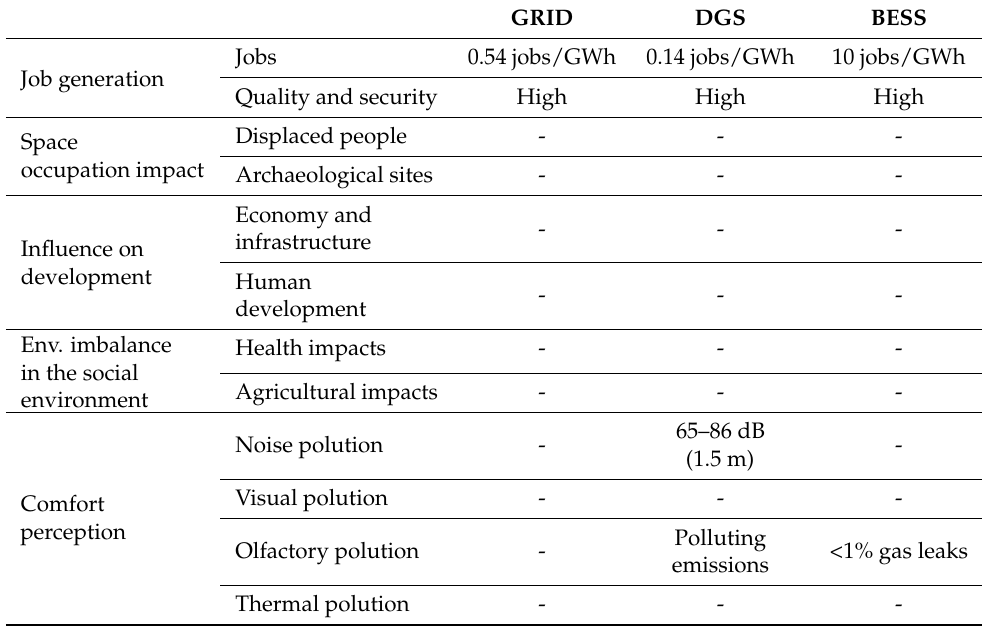
Table 6. Social dimension assessment under RCPA tool for GRID (3rd column), the DGS (4th column) and the BESS (5th column).